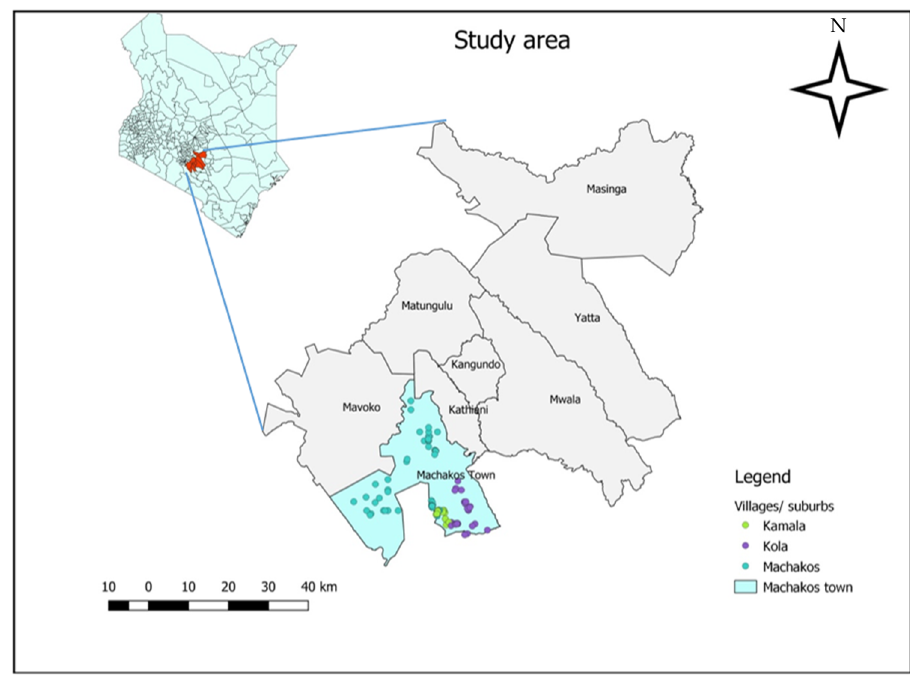
Figure 1. Map showing study area in blue.